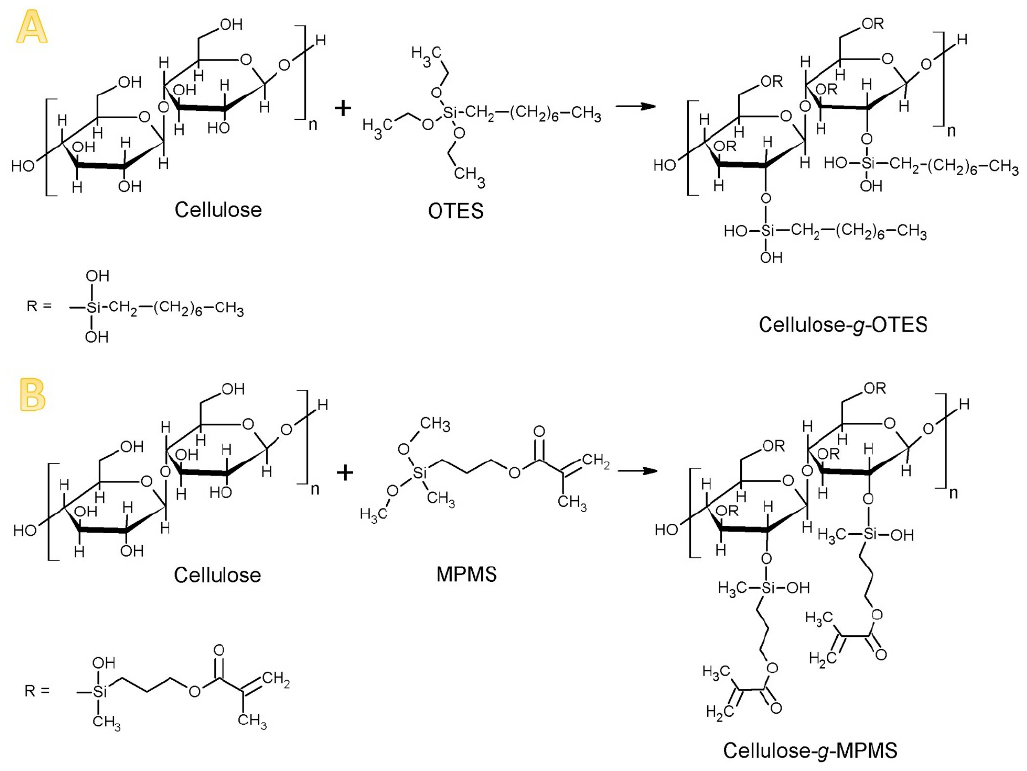
Figure 1. Schematic presentation of the modification of cellulose unit by ( A ) octyltriethoxysilane (OTES) and ( B ) (3-methacryloxypropyl)methyldimethoxysilane (MPMS).